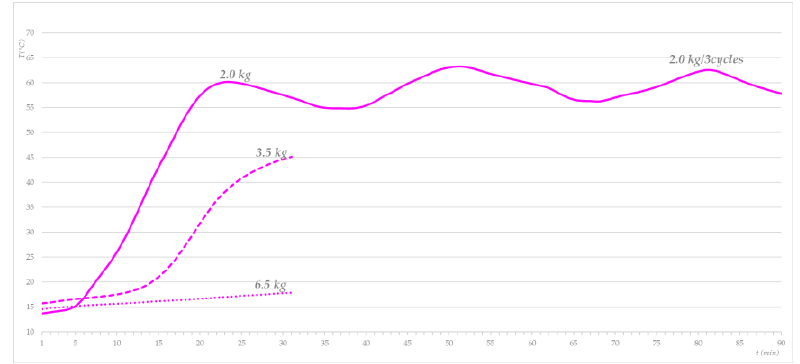
Figure 8. Temperature profile for different cotton base loads treated with saturated steam.